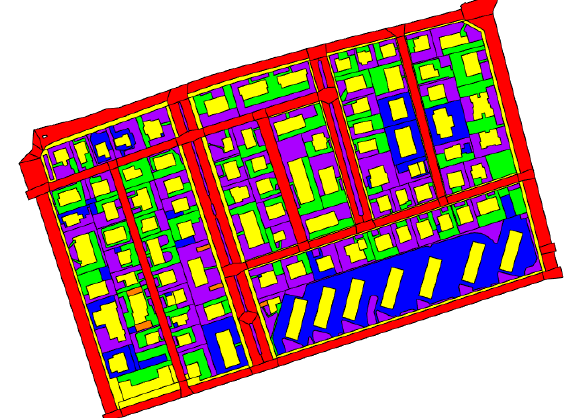
Figure 3. Illustration of the classification detail for test area